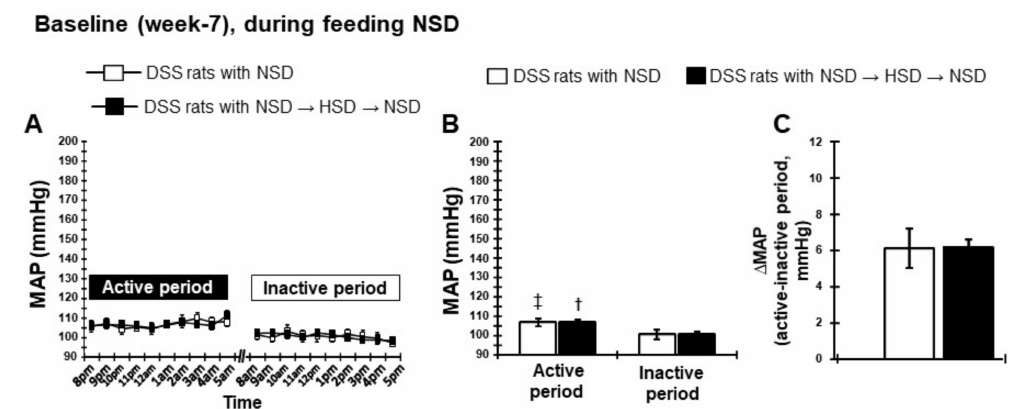
Figure 2. Circadian rhythm of MAP at baseline during feeding normal salt diet (NSD, 0.3% NaCl diet at week 7). ( A ) Hourly MAP with NSD, ( B ) averaged 10-h MAP in active and inactive periods, and ( C ) the di ff erence of 10-h MAP between active and inactive periods. † p < 0.05, DSS rats with NSD → HSD → NSD (inactive period) vs. DSS rats with NSD → HSD → NSD (active period); ‡ p < 0.05; DSS rats with NSD (inactive period) vs. DSS rats with NSD (active